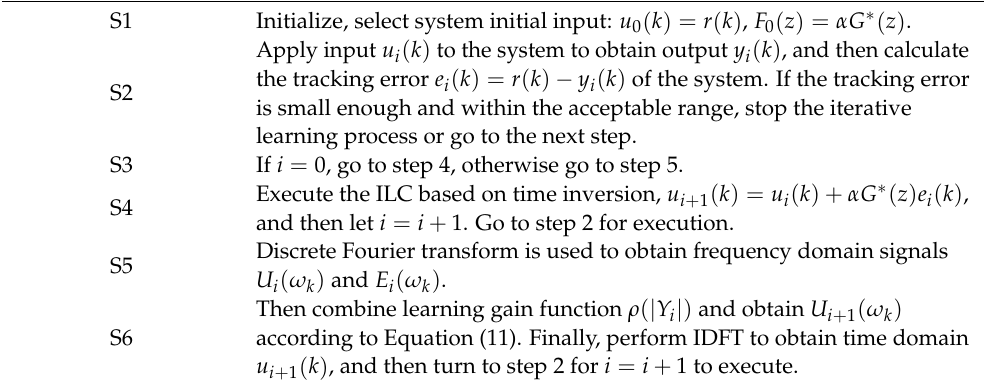
Algorithm 2: Data-driven nonlinear iterative inversion learning control based on